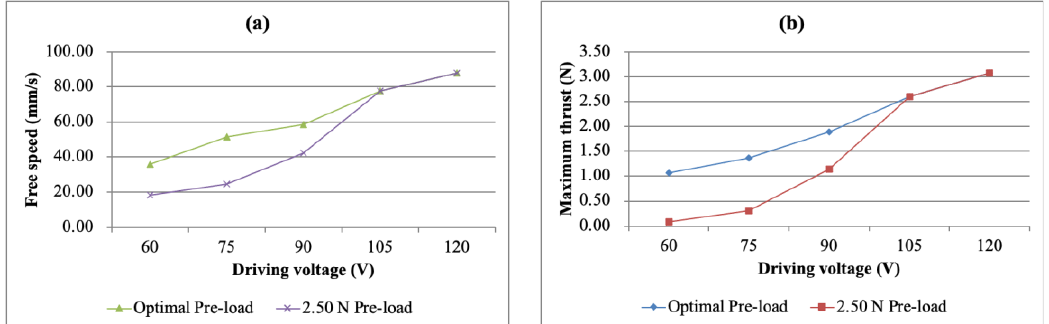
Figure 14. ( a ) Free speed and ( b ) maximum thrust as a function of the driving voltage for the simple bimorph USM under different pre-loads. bimorph USM under different